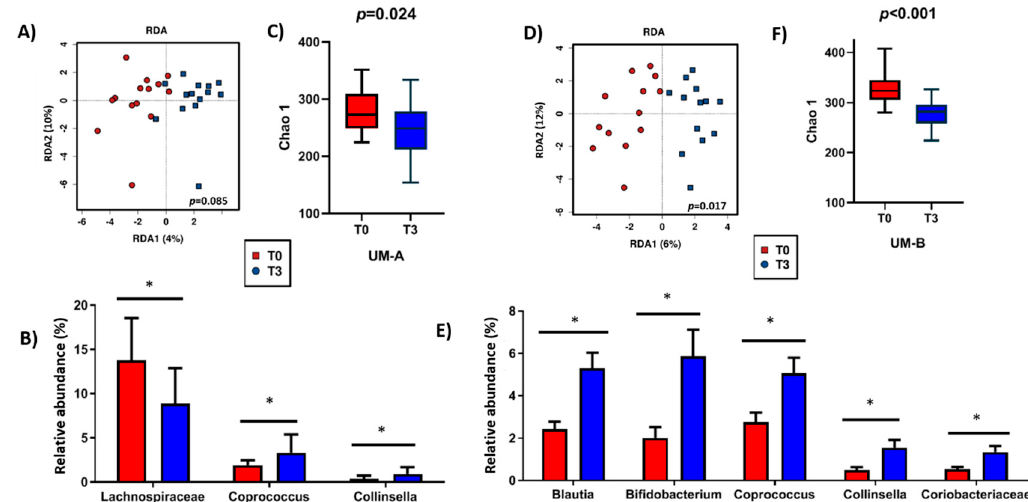
Figure 2. Effect of the intervention with walnuts in gut microbiota composition ( A,B ) and diversity ( C ) in UM-A and in gut microbiota composition ( D,E ) and diversity ( F ) in UM-B. ANOVA test was used to test significance differences in the relative abundances before and after the intervention. Alpha diversity measured by Chao1 index. Results are presented as mean ± SD. Significant differences ( p < 0.05) are marked with an asterisk (*).